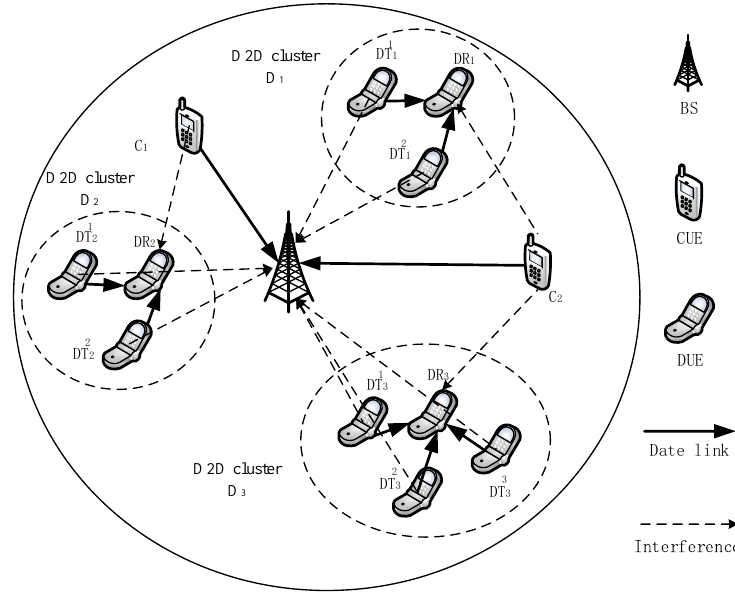
Figure 1. System model (physical domain).